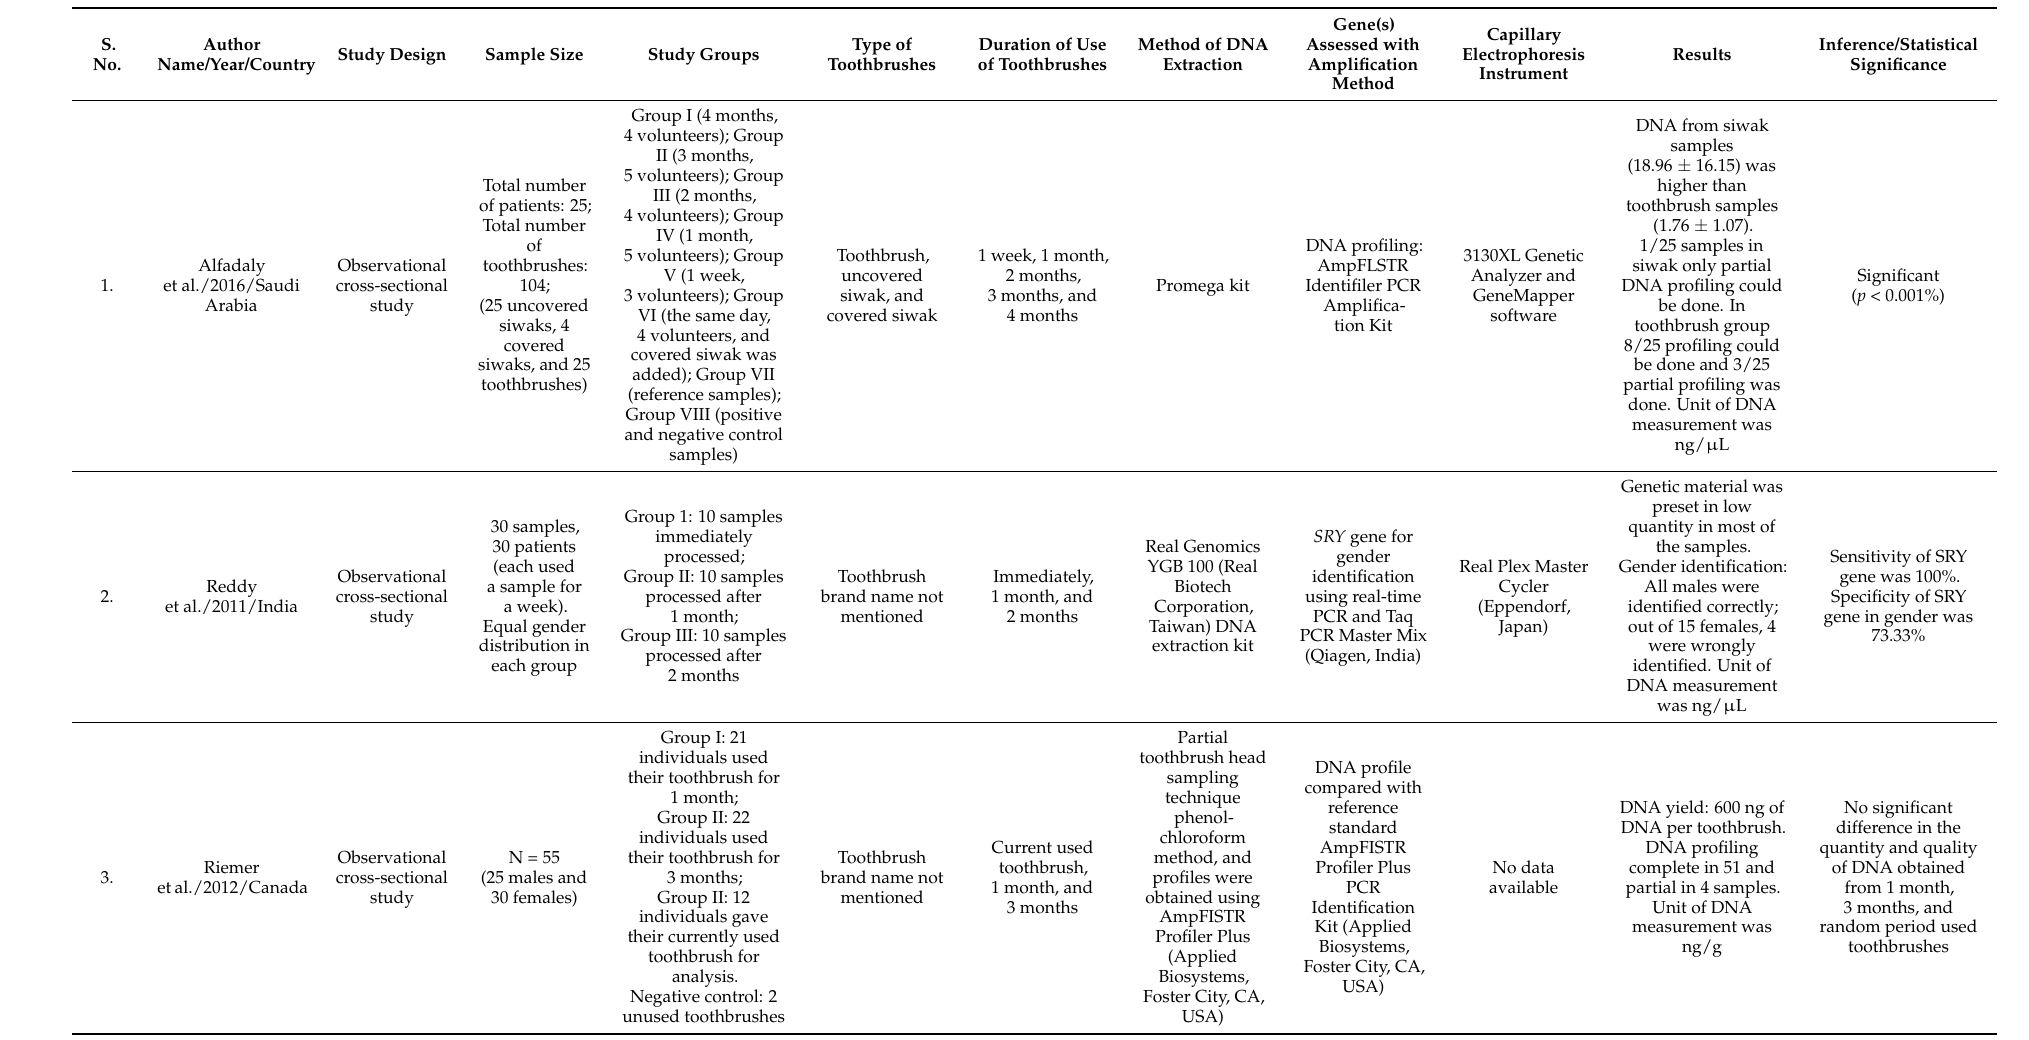
Table 1. Characteristics and detailed description of the included